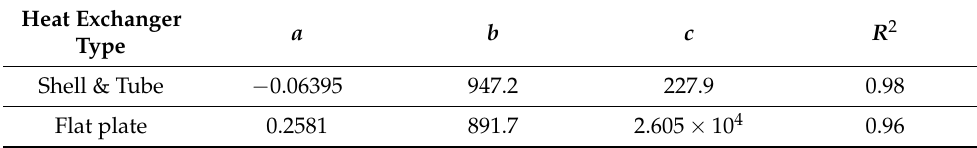
Table 6. The coefficients of Equation (3) for heat